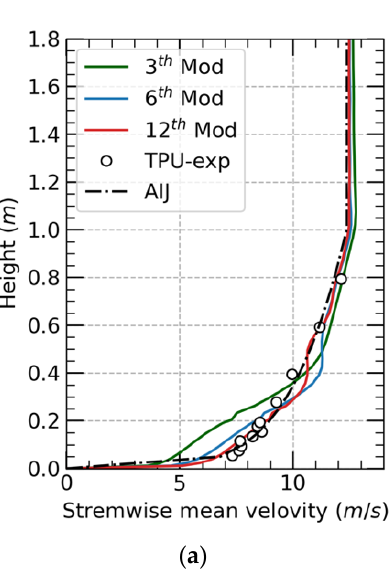
Figure 6. Streamwise velocity field in the crosswise central plane after recycling and reshaping modification. The colors from blue to red represent the streamwise velocity from zero to high value.